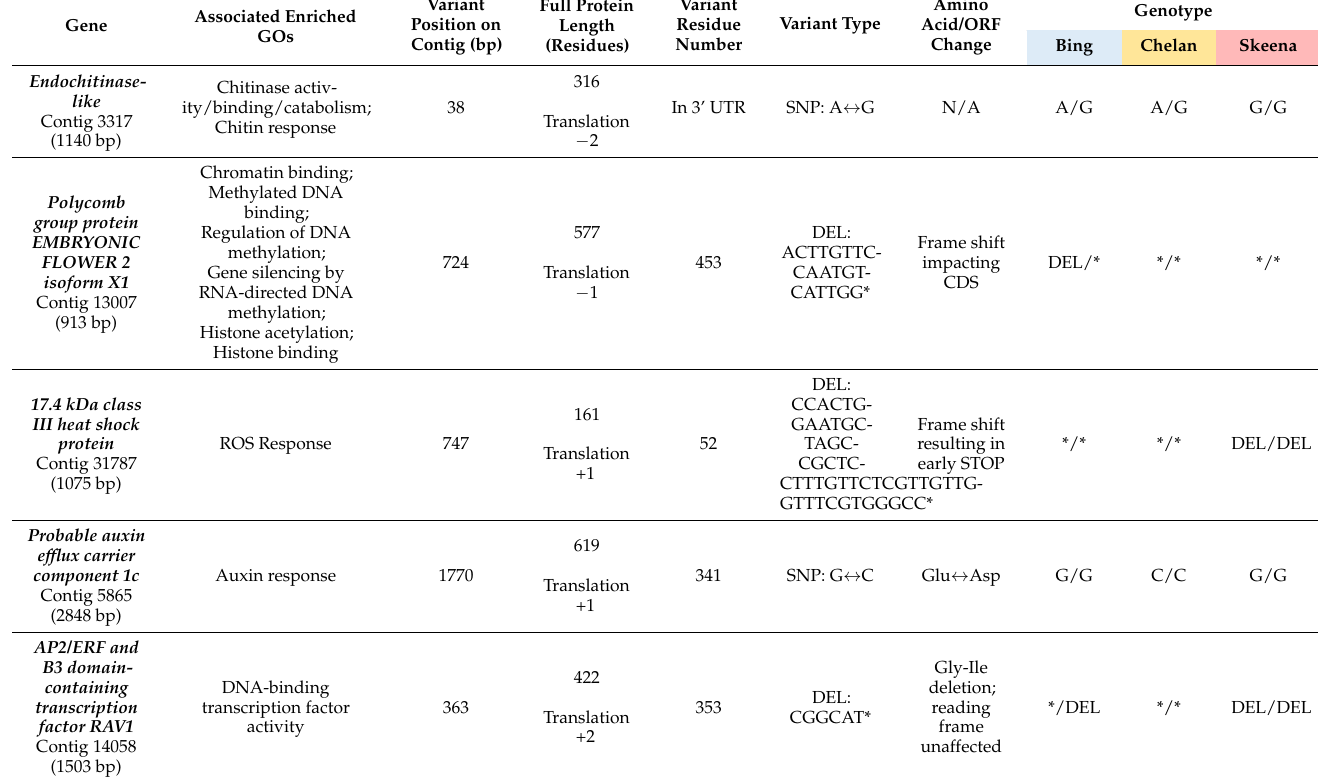
Table 1. Variants identified in differentially expressed genes. The GATK RNAseq short variant discovery pipeline was used for the characterization of SNPs and indels [45]. Information regarding the associated enriched gene ontology (GO) terms, variant position, full protein length, residue number, type of variant, and whether the variants identified result in a change in amino acid sequence or open reading frame (ORF) is shown. Asterisks reference overlapping